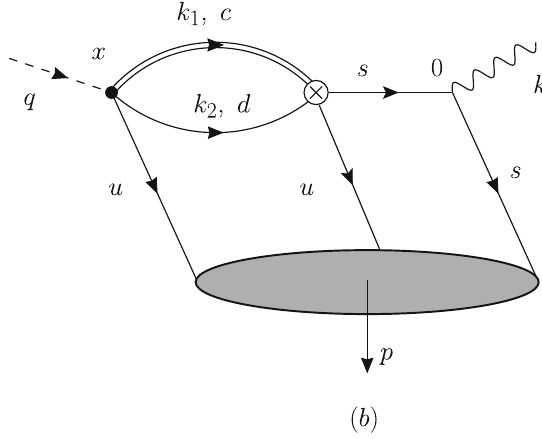
Fig. 2 Diagrams for the QCD level correlation function in Eq. (18). a Is the initial quark radiation where the white crossed dot denotes the effective four-quark currents in Eq. (7). b is the final s quark radia-